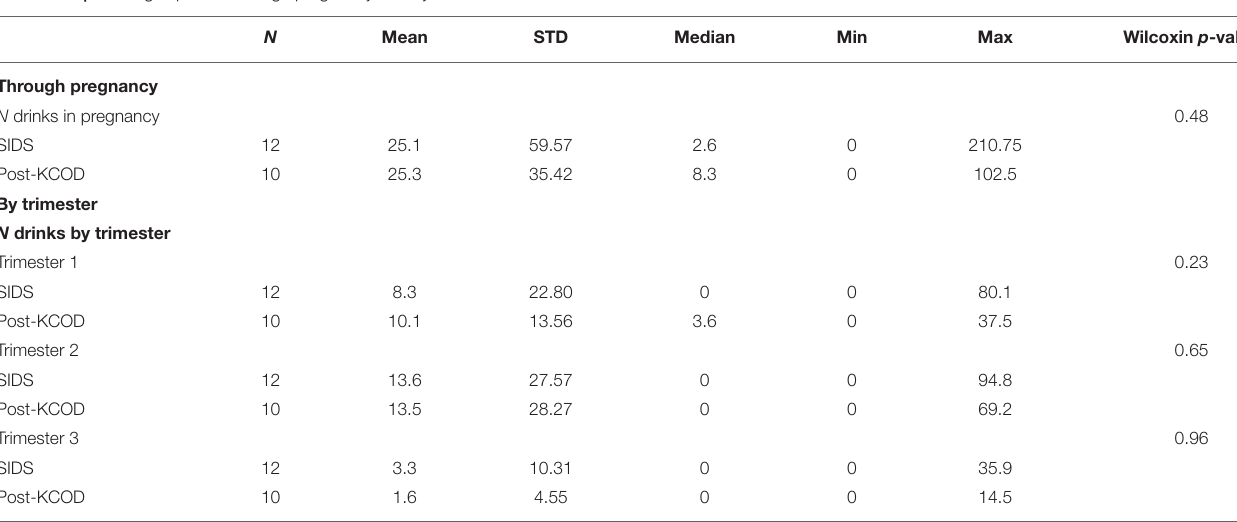
TABLE 3B | Drinking exposure through pregnancy and by